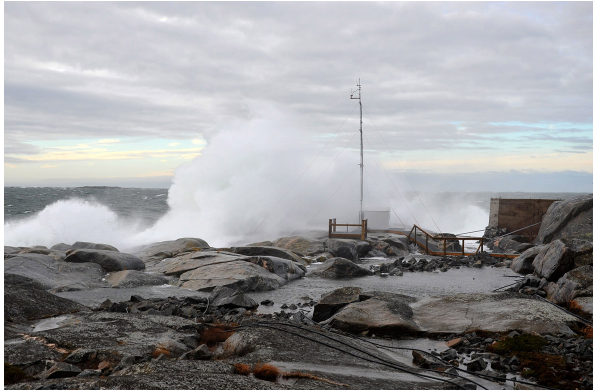
Figure 2. The flux tower (height 9m) on the shore of the island of Utö during a wintertime westerly storm (photo by Ismo